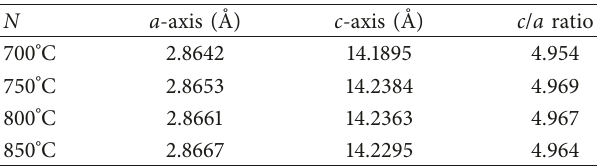
1/3 Co 1/3 Mn 1/3 O 2 powders pre-